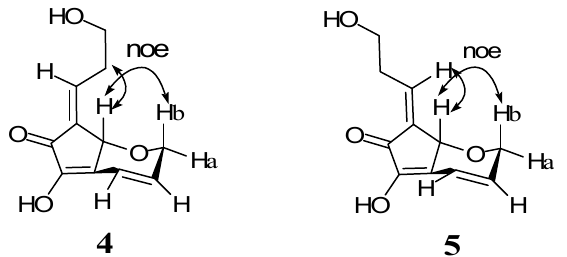
Figure 3. Selected NOEs of compounds 4 and 5